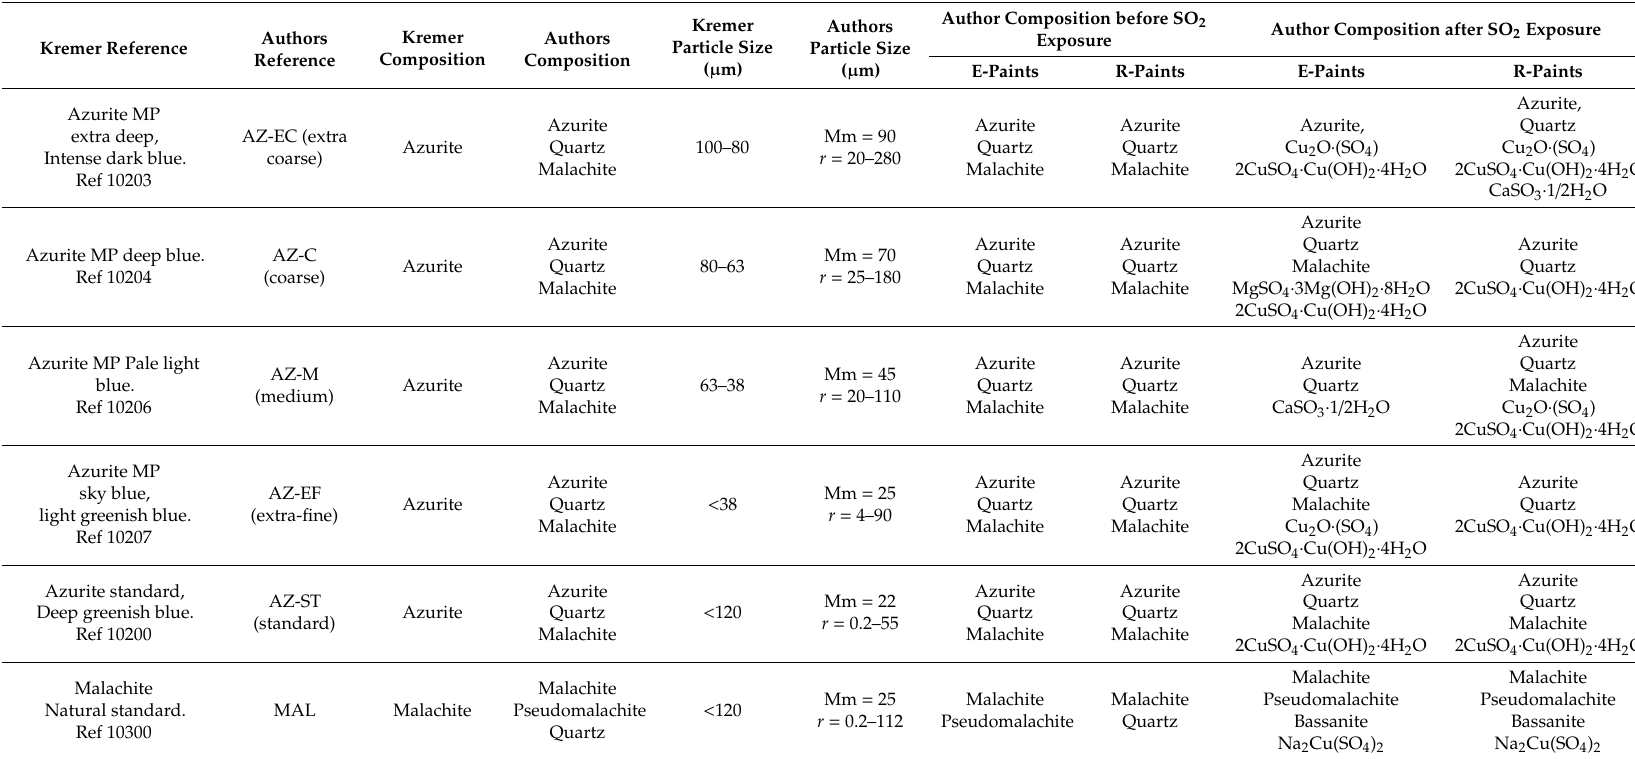
Table 1. For each pigment, Kremer and author’s references, mineralogical composition (by means of XRD) and grain size ( µ m) according to Kremer supplier and to the authors [22], mineral phases identified in the mock-ups by XRD before and after SO 2 exposure of the temperas. E: egg yolk-based paints and R: rabbit glue-based mock-ups. Mm: maximum grain size and r : grain size range.